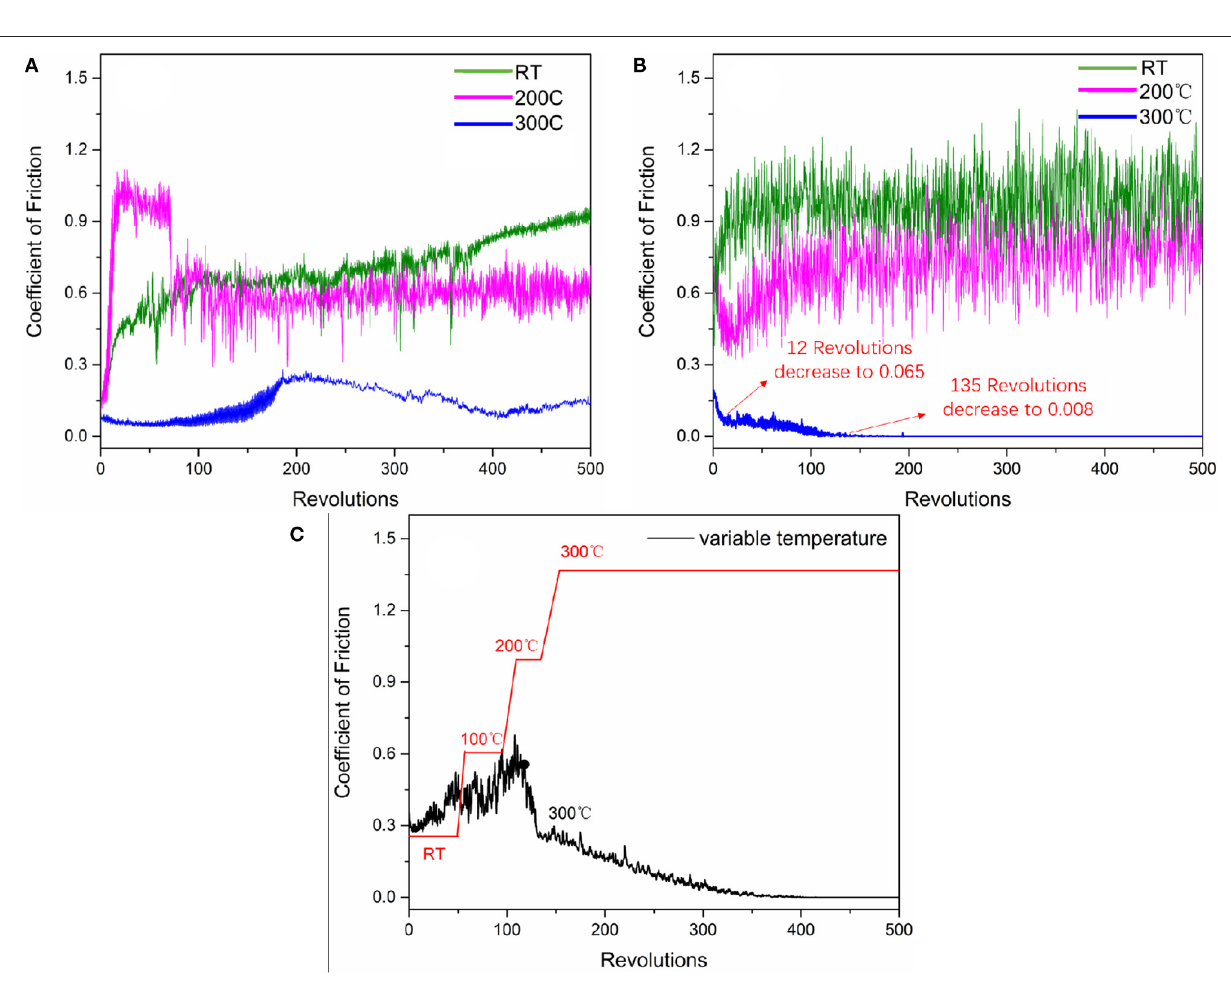
Frontiers in Chemistry |